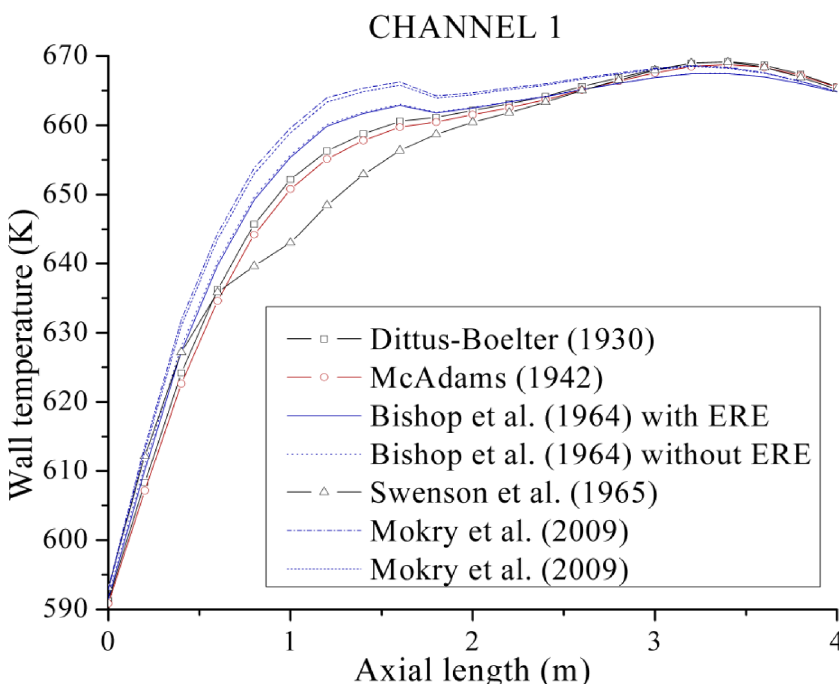
Fig. 8. Simulation results for Channel 1 showing the wall temperature behavior for different